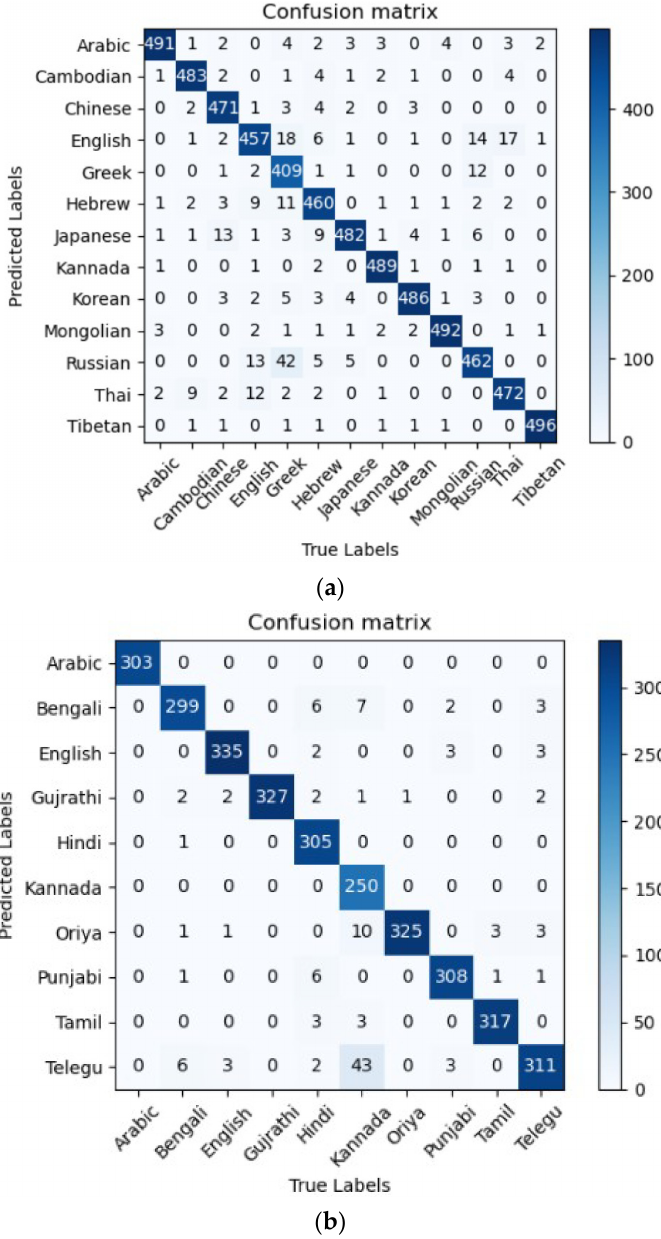
Figure 10. Confusion matrix on two publicly available datasets. The x-coordinates and y-coordinates represent the real label and the predicted category, respectively, and the darker the color, the higher the proportion of correct predictions. ( a ) SIW-13, ( b ) CVSI-2015.